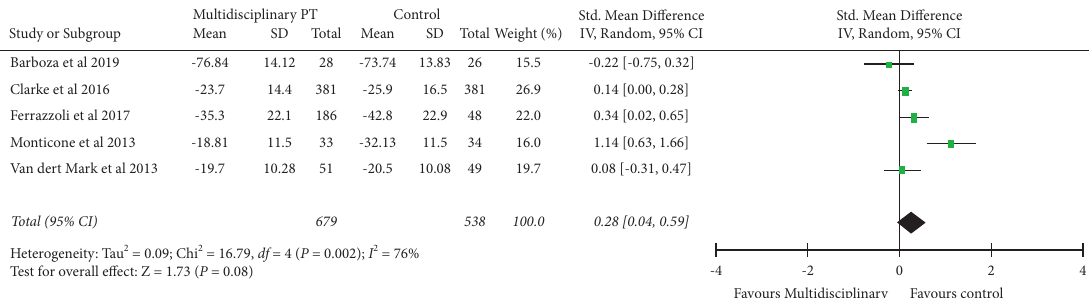
Figure 4: Forest plot multidisciplinary physiotherapy with the control group: quality of